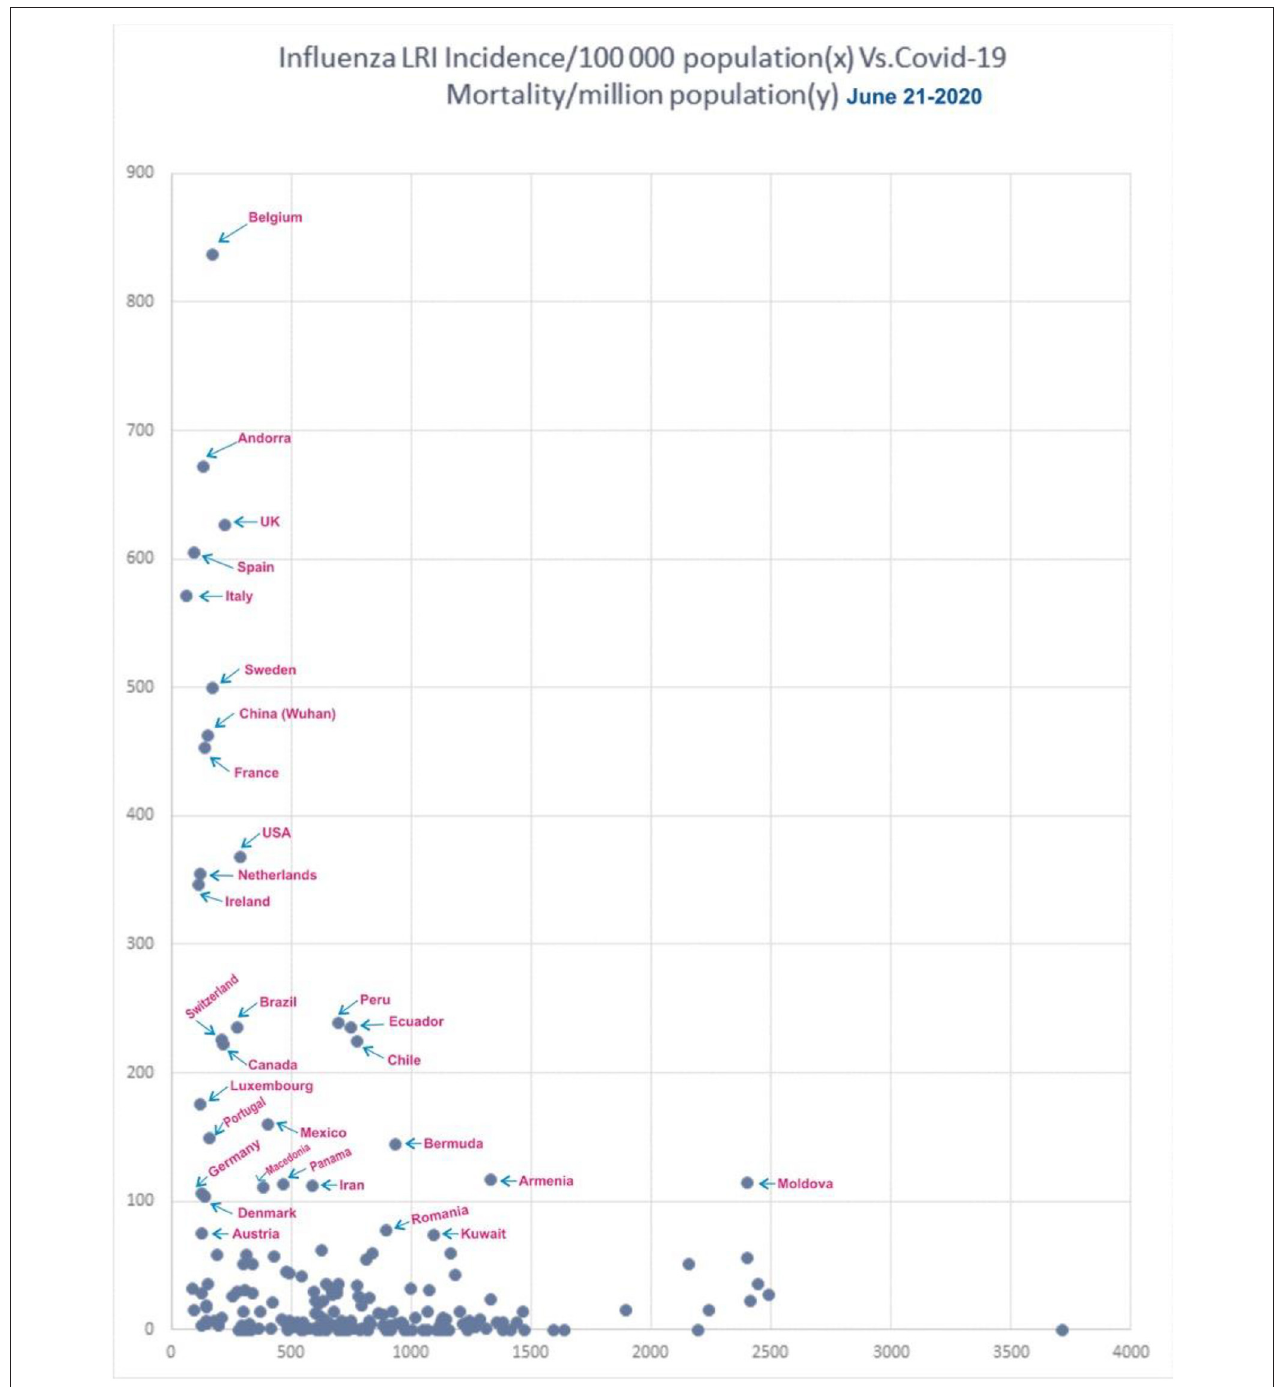
FIGURE 9 | Correlation of influenza incidence/100,000 population and COVID-19 mortality/million population ( n = 182, June 21, 2020). − 1.43 to 0.77, P = 0.558) with COVID-19 mortality (COVID-19 CI − 5.7 to − 1.9, P < 0.0001, and population density OR was − 0.45 (CI − 1.54 to 0.64, P = 0.4). To predict the parameter, mortality/influenza LRI episodes > 1,000, July 9, 2020), whereas the COVID-19 mortality/Influenza LRI episodes ∗ 1,000 value influenza LRI’s events were significantly associated (OR − 3.8, CI > 1,000, the influenza LRI parameter had an odds ratio of − 5.98 to − 1.67, P = 0.001). For COVID-19 mortality/influenza − 3.83 (CI − 5.98 to − 1.67). To predict COVID-19 LRI episodes > 500, the Influenza LRI values were OR − 3.8,